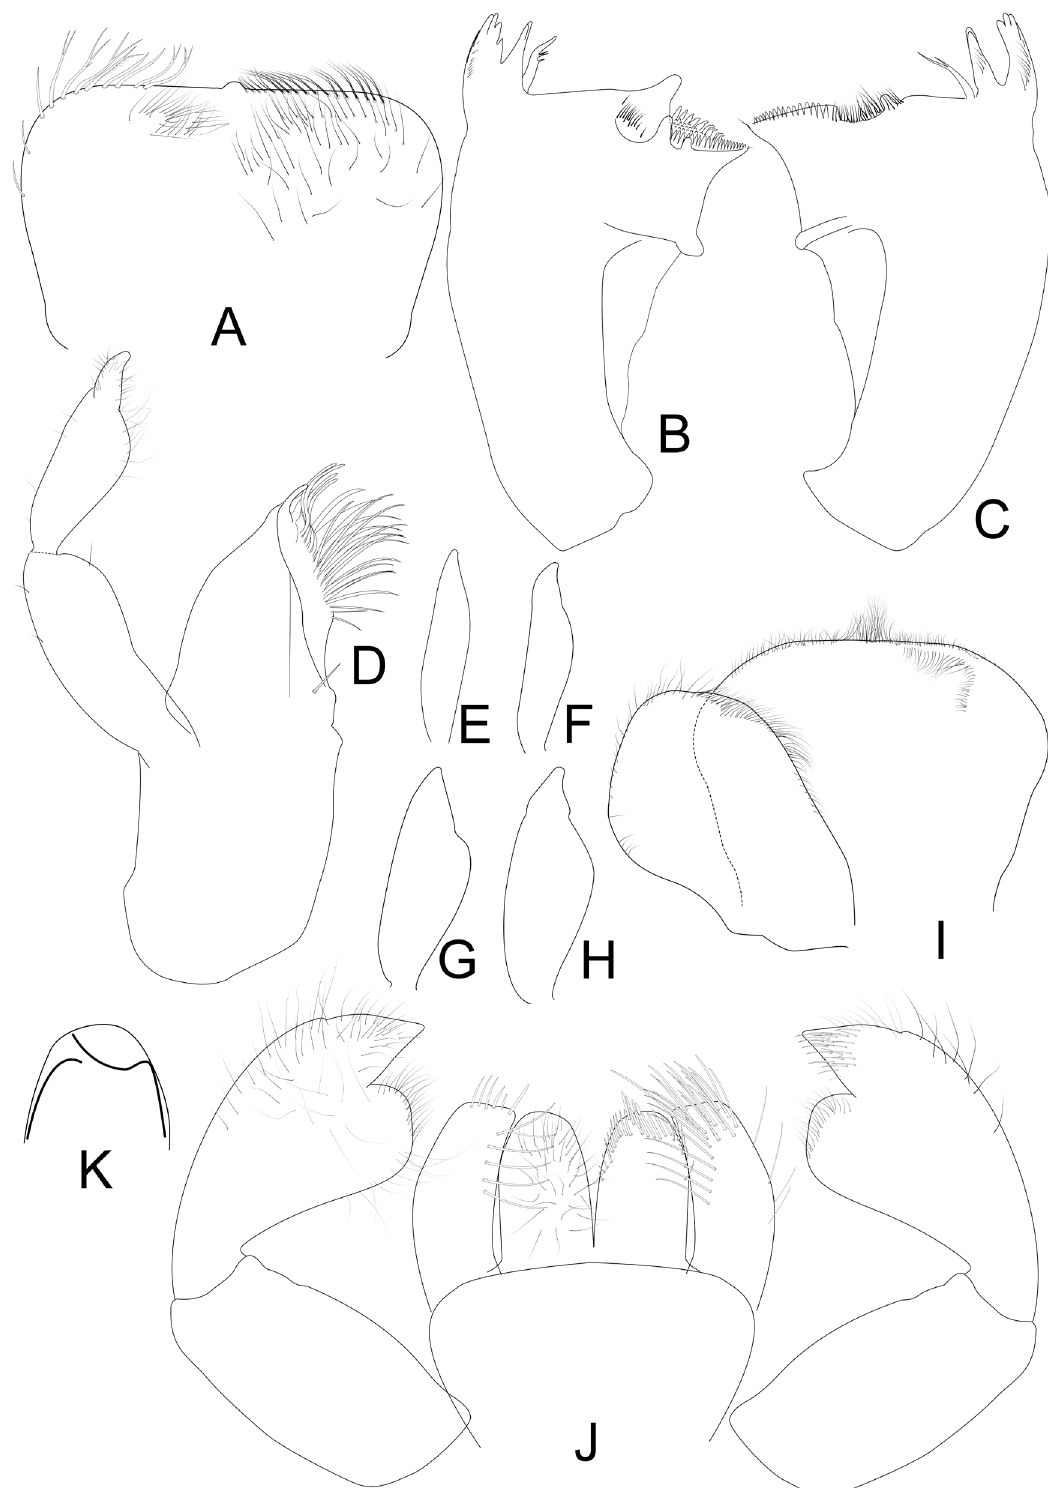
Fig. 8. Rivudiva oxum sp. nov. A–D, I–K . Holotype (INPA). E–H . Paratypes (INPA). A . Labrum (left v.v., right d.v.). B . Left mandible. C . Right mandible. D . Maxilla. E–H . Variation of maxillar palp segment II ( E–F is related to slide mounting). I . Hypopharynx. J . Labium (left v.v., right d.v.). K . Shape of distal rows of setae of glossa. Not to